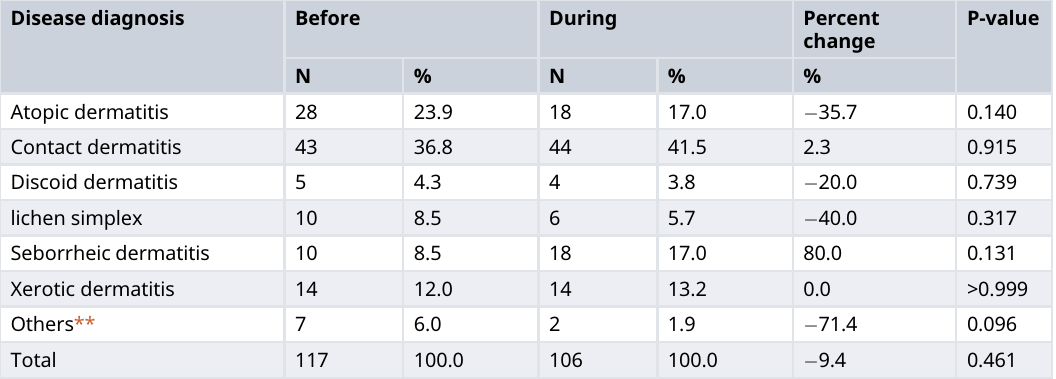
Table 7. The types of dermatitis types before and after the coronavirus disease 2019 (COVID-19) pandemic. Disease